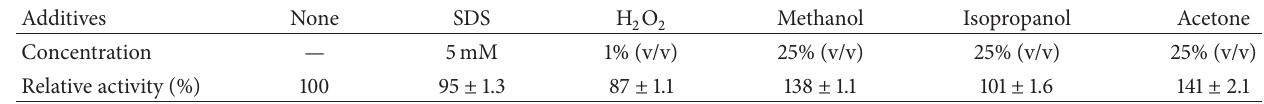
Table 4: Influence of crude alkaline protease activity by organic solvents and